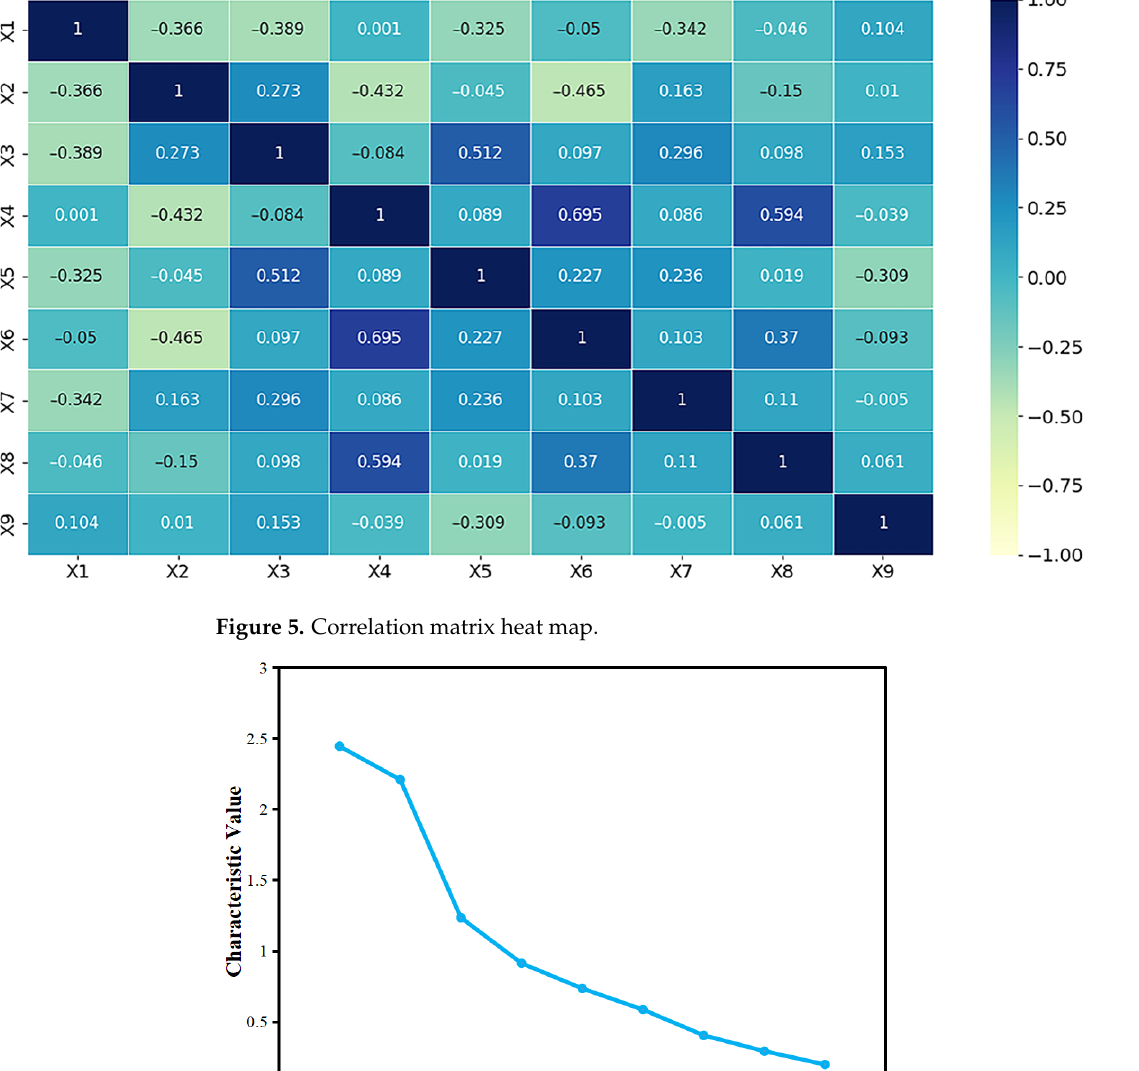
Figure 5. Correlation matrix heat map.